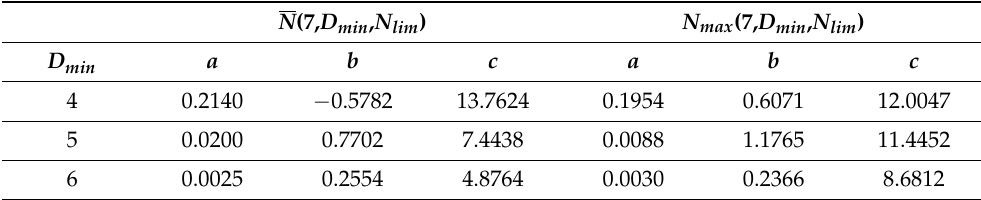
Table 4. Coefficients of quadratic approximation polynomials for N ( 7, D min , N lim ) and N max ( 7, D min , N lim )